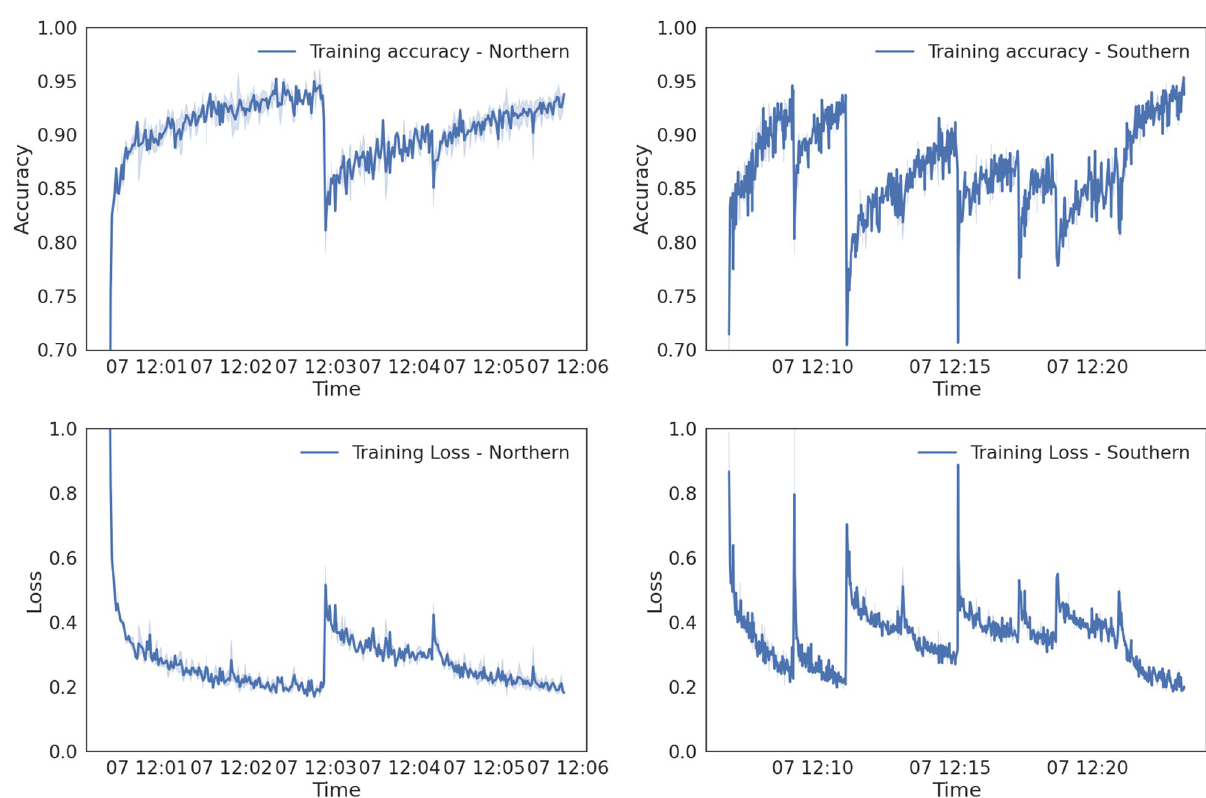
Fig 5. The training accuracy and loss metrics (top and bottom rows of panels, respectively) logged during the training procedures of the two LSTM neural networks, for the Northern (left column) and Southern clusters (right column) of federal regions. The jumps observed in both metrics indicate the point in time in which the callback function interrupted training on one federal region and carried on to the